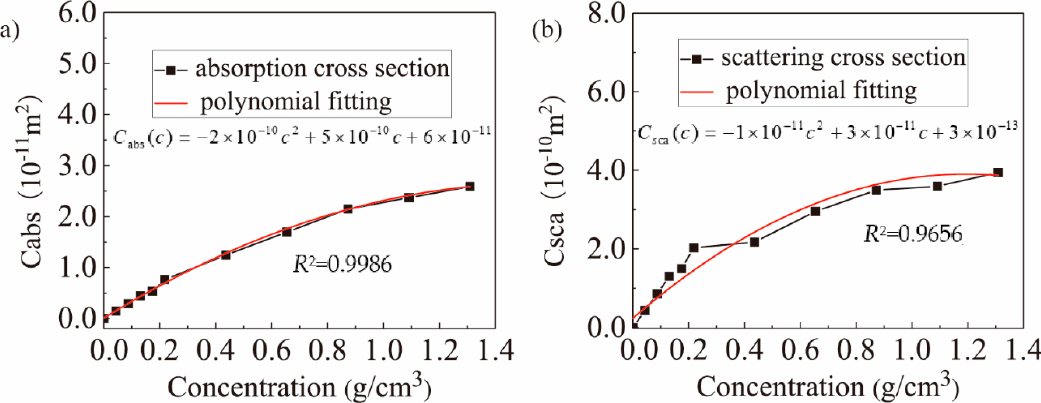
Figure 6. Fitting graph of math model. ( a ) The relationship between the C abs value and concentration. ( b ) The relationship between the C sca value and concentration.